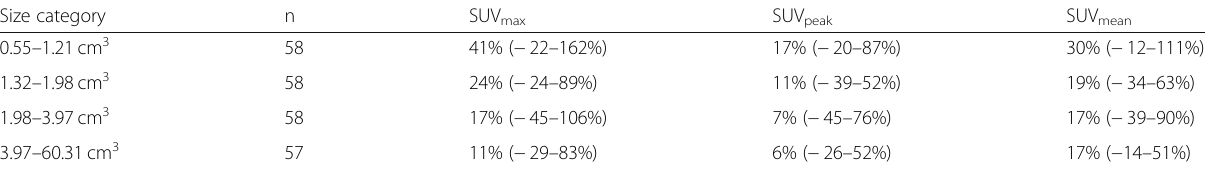
Table 2 Median (IQR) differences between SUVs of SPECT and PET for lesions in different size categories. The differences are normalized with respect to SPECT SUVs